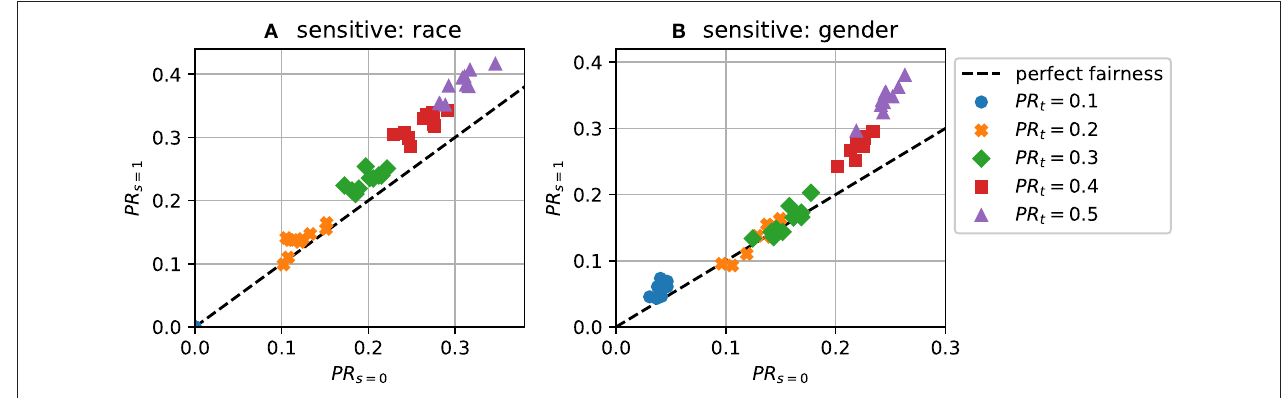
FIGURE 2 | Predictions with different target acceptance rates (demographic parity) for 10 repeats. (A) PR s = 0 vs PR s = 1 using race as the sensitive attribute; (B) PR s = 0 vs PR s = 1 using gender.